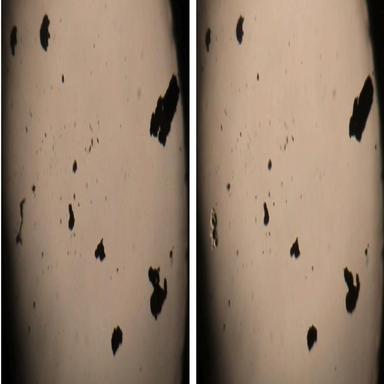
Images captured under the optical microscope: a) start of heating and b) start of the melting phase.